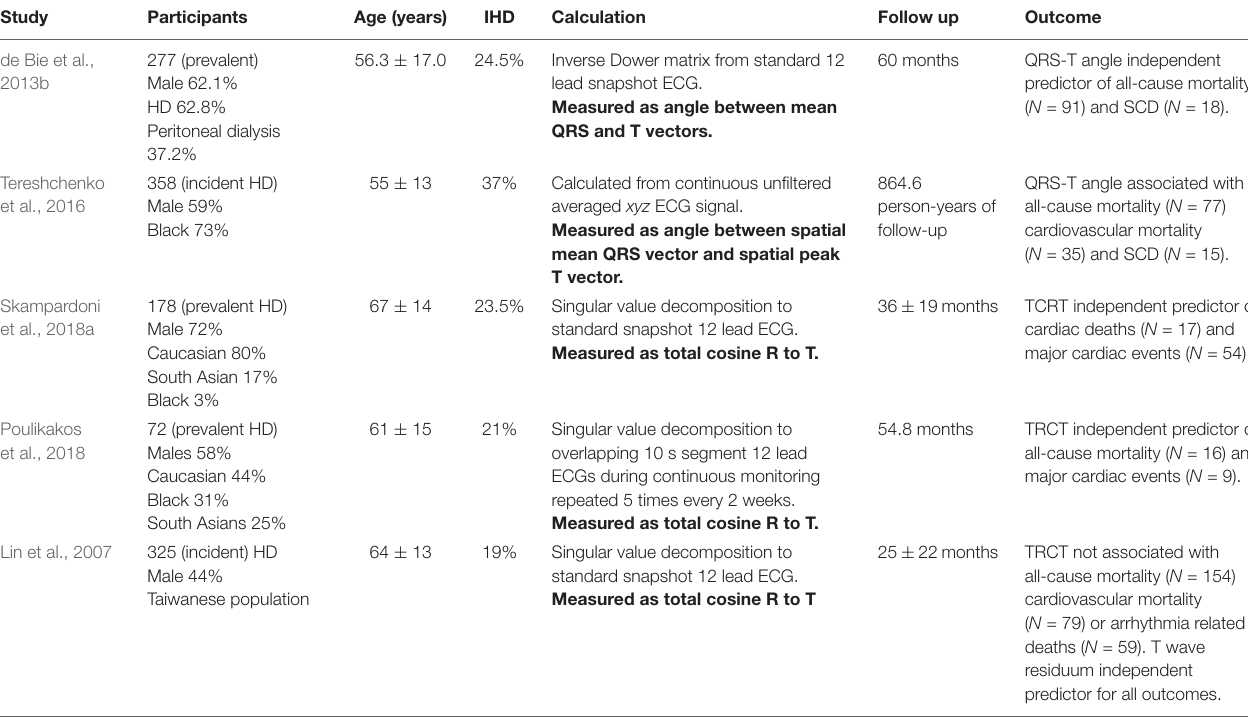
TABLE 3 | Studies of QRS-T angle for risk prediction in dialysis patients.